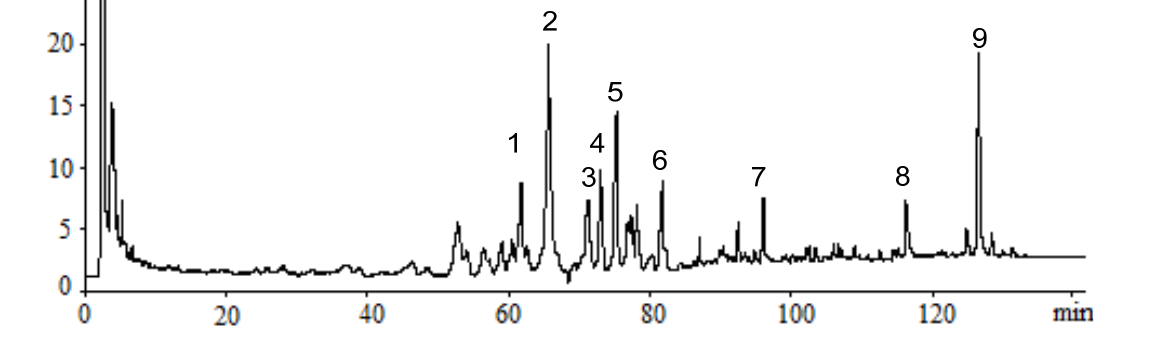
Figure 2. The chemical structures of triterpenes of